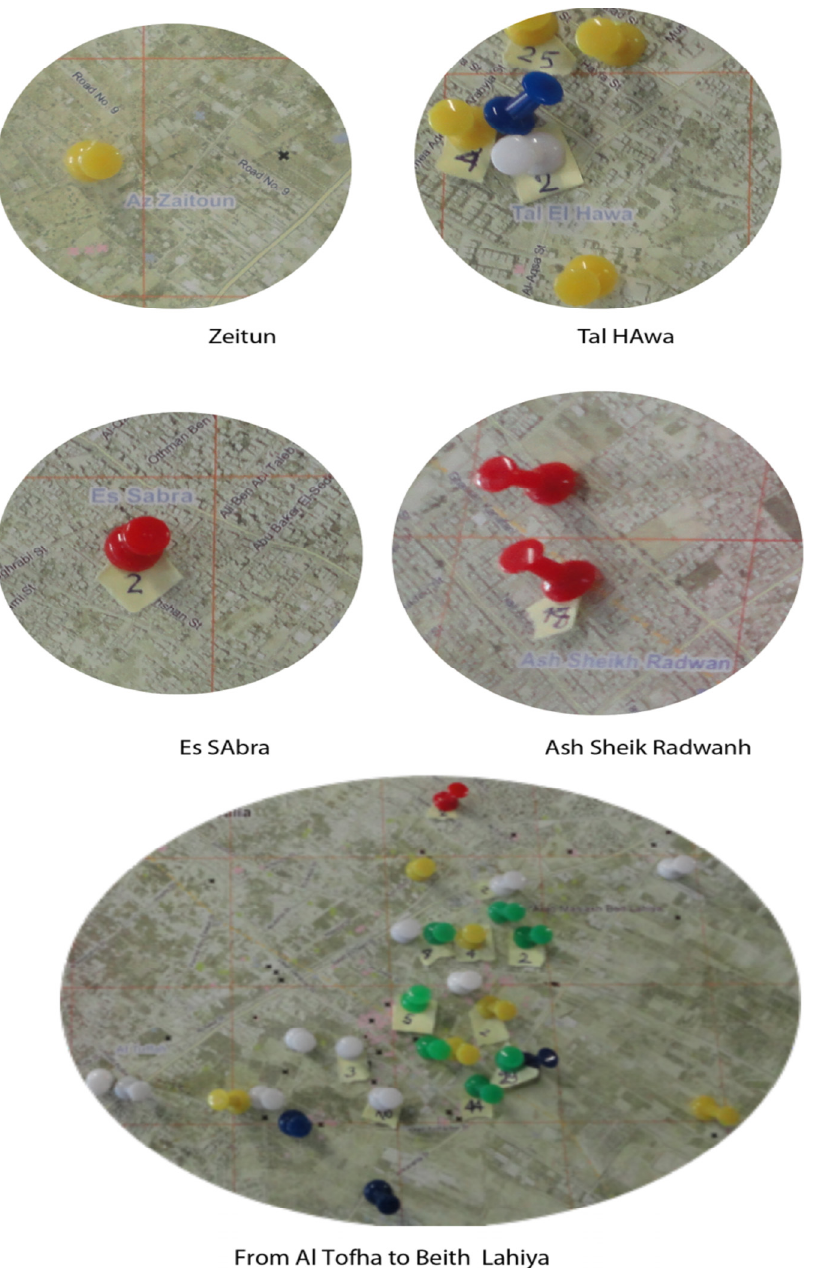
Figure 3. Mapping of the exposure to